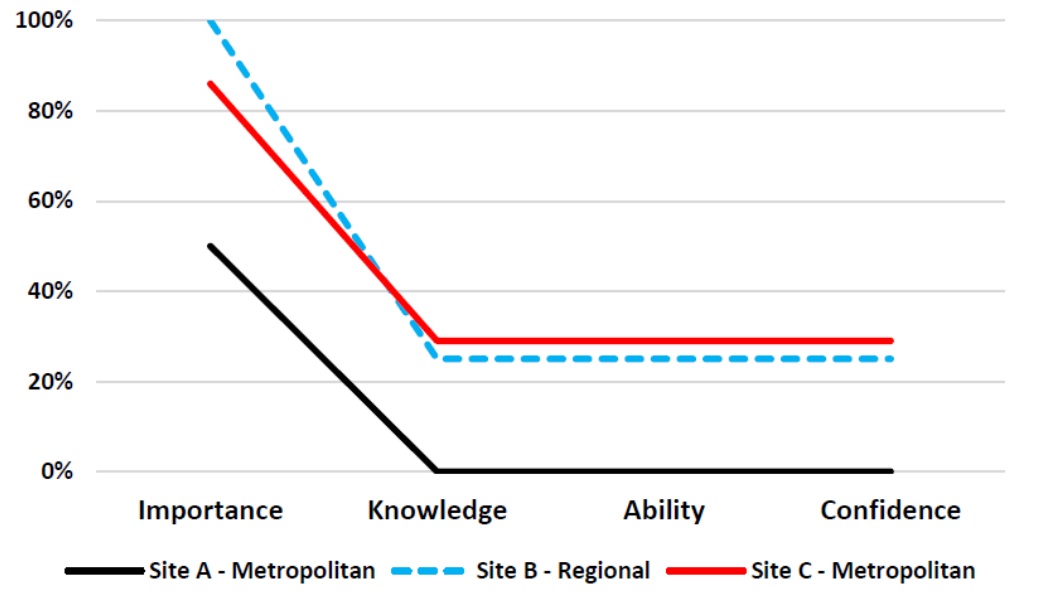
Figure 3. Proportion of nursing staff who rated ‘ high ’ the importance, knowledge, ability and confidence to communicate with Indigenous Australian patients.